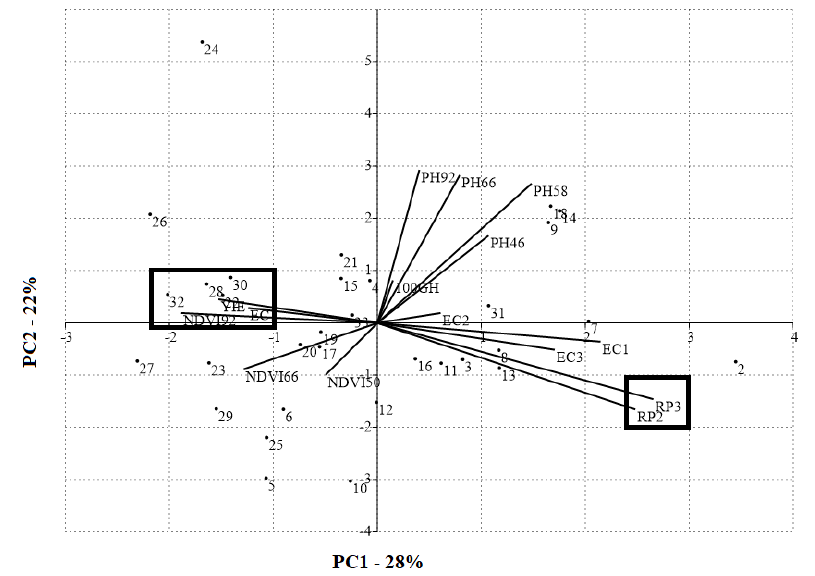
Figure 4. Principal component analysis applied to the different sample sites evaluated under variable seeding rate and fixed seeding